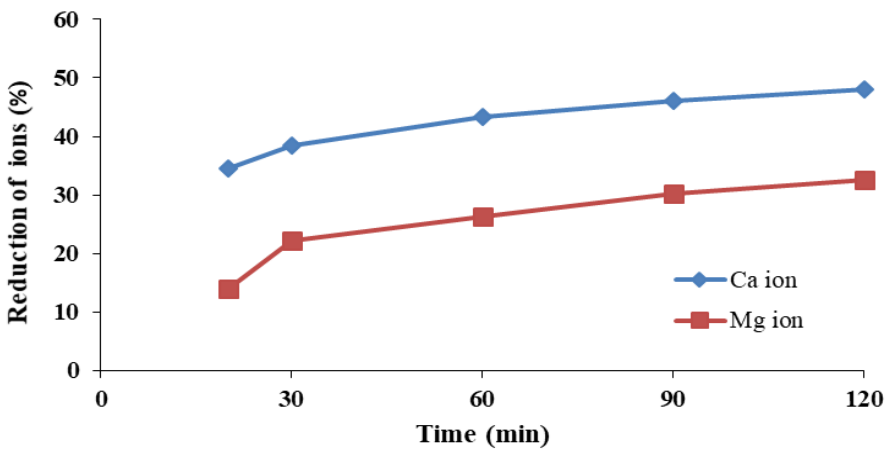
Figure 13. The effect of activated alumina in reducing calcium and magnesium ions in drinking